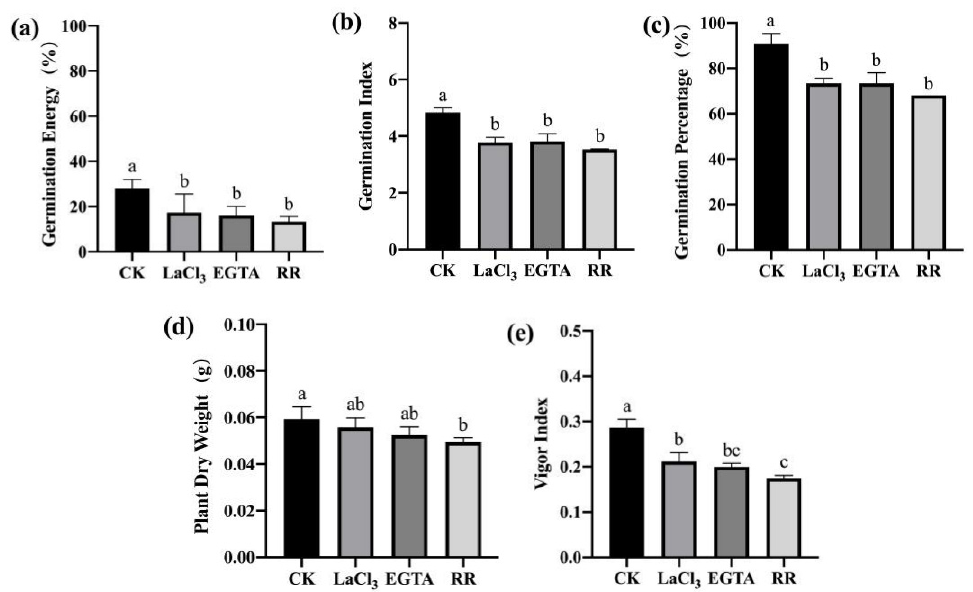
Figure 6. Ca 2+ chelating agent/channel inhibitor treatments reduced F. graminearum resistance in low-vigor maize seeds. ( a ) germination energy (%), ( b ) germination index, ( c ) germination percentage (%), ( d ) dry weight of single plant (g), ( e ) vigor index. EGTA, ethylene glycol-bis(beta-aminoethyl ether)- N -tetraacetic acid; RR, Ruthenium Red; CK, control. Different letters indicate significant differences among different lines (Tukey’s test).